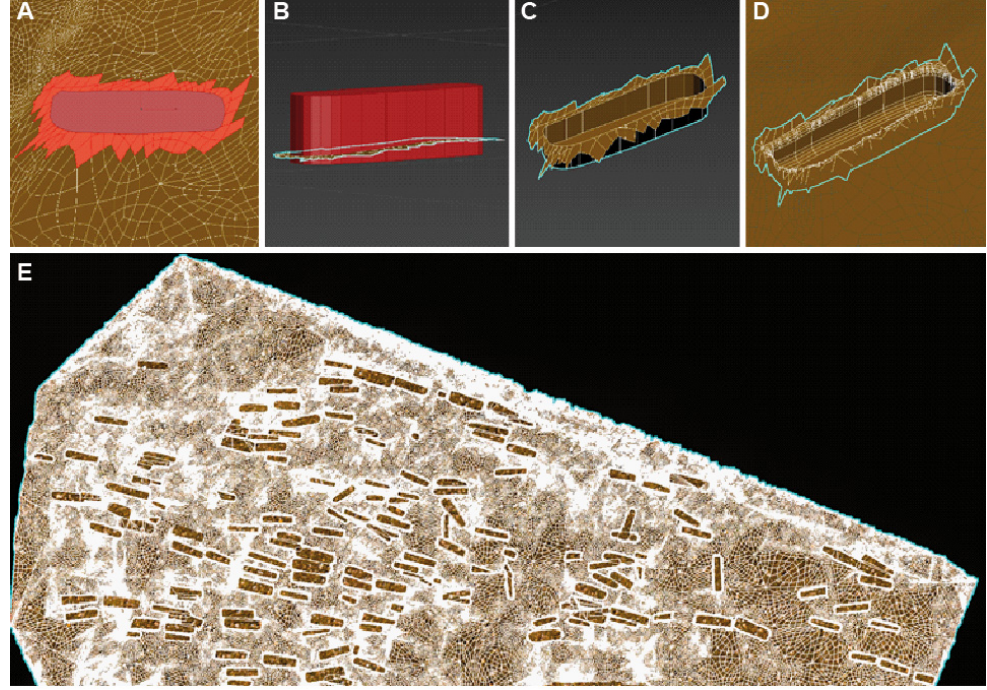
Figure 3. ( A – D ) Four steps in the process of rebuilding a grave; ( E ) Wired mesh of the “bottom of form” with the tombs north of the embankment.